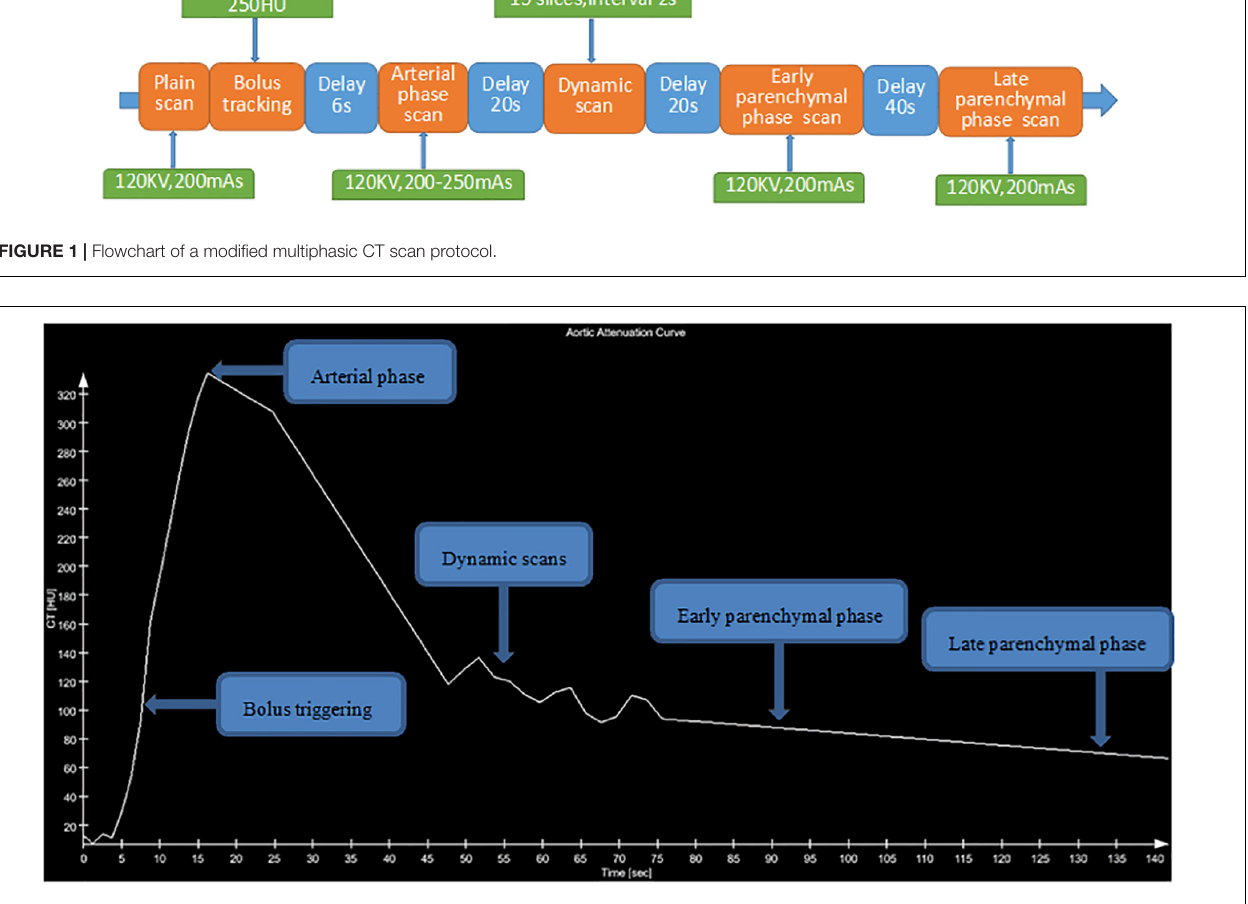
FIGURE 2 | Aortic attenuation curve. Graph shows aortic attenuation curve of a 35-year-old man with unilateral renal tumor. Five clusters of data points were measured with CT. The area under the curve was determined